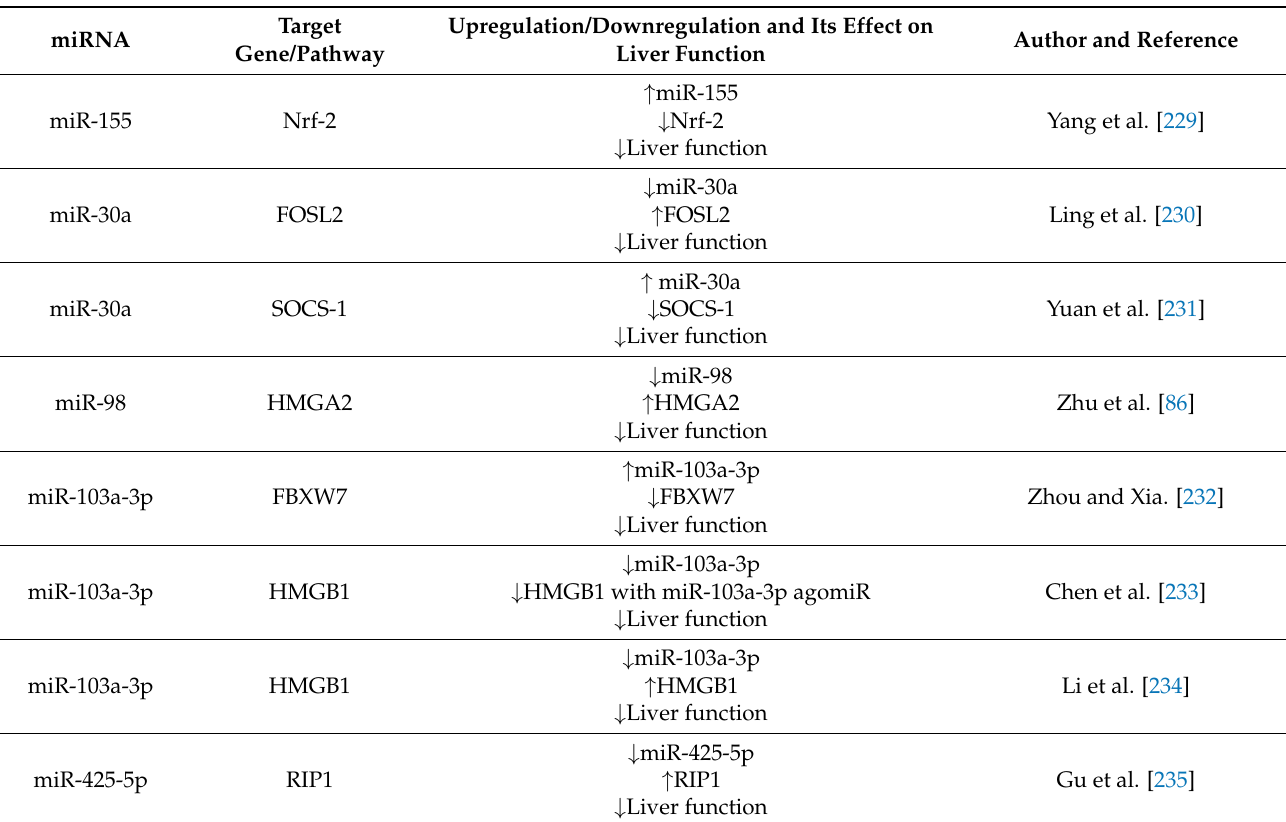
Table 11. miRNAs involved in sepsis-induced liver dysfunction and their targets. ↑ indicates up regulation, ↓ indicates down